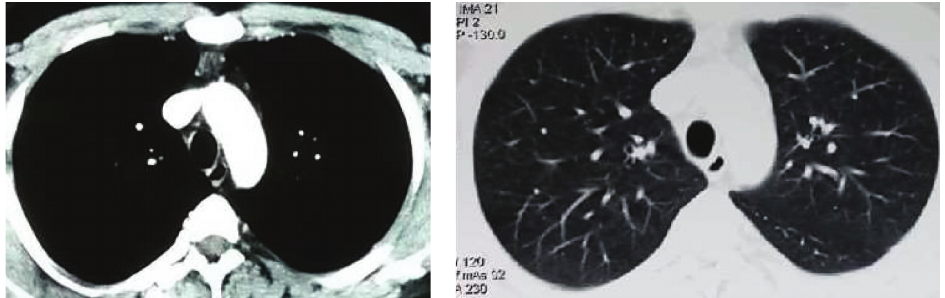
Figure 6: CT sections at the 6th month: tracheal lumen is